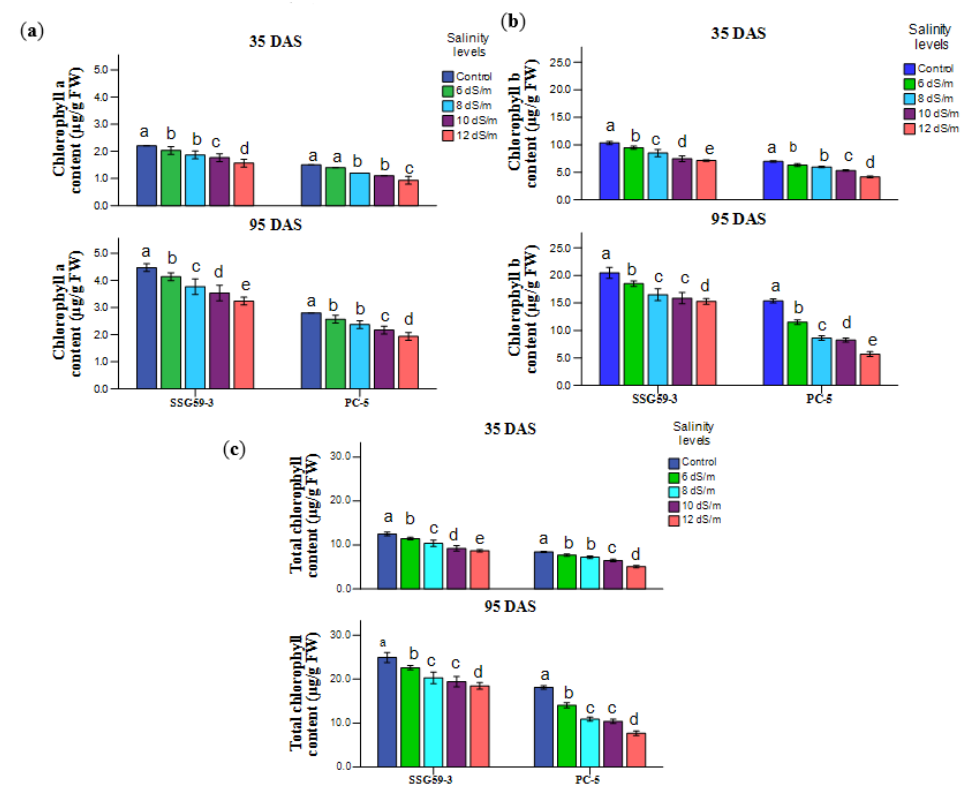
Figure 4. Effect of salt stress on ( a ) chlorophyll a, ( b ) chlorophyll b, and ( c ) total chlorophyll of sorghum genotypes at 35 and 95 DAS. Post hoc comparisons of the means were performed using Tukey’s HSD test at p < 0.05; different letters ( a–e ) indicate significant differences among treatments within each genotype.